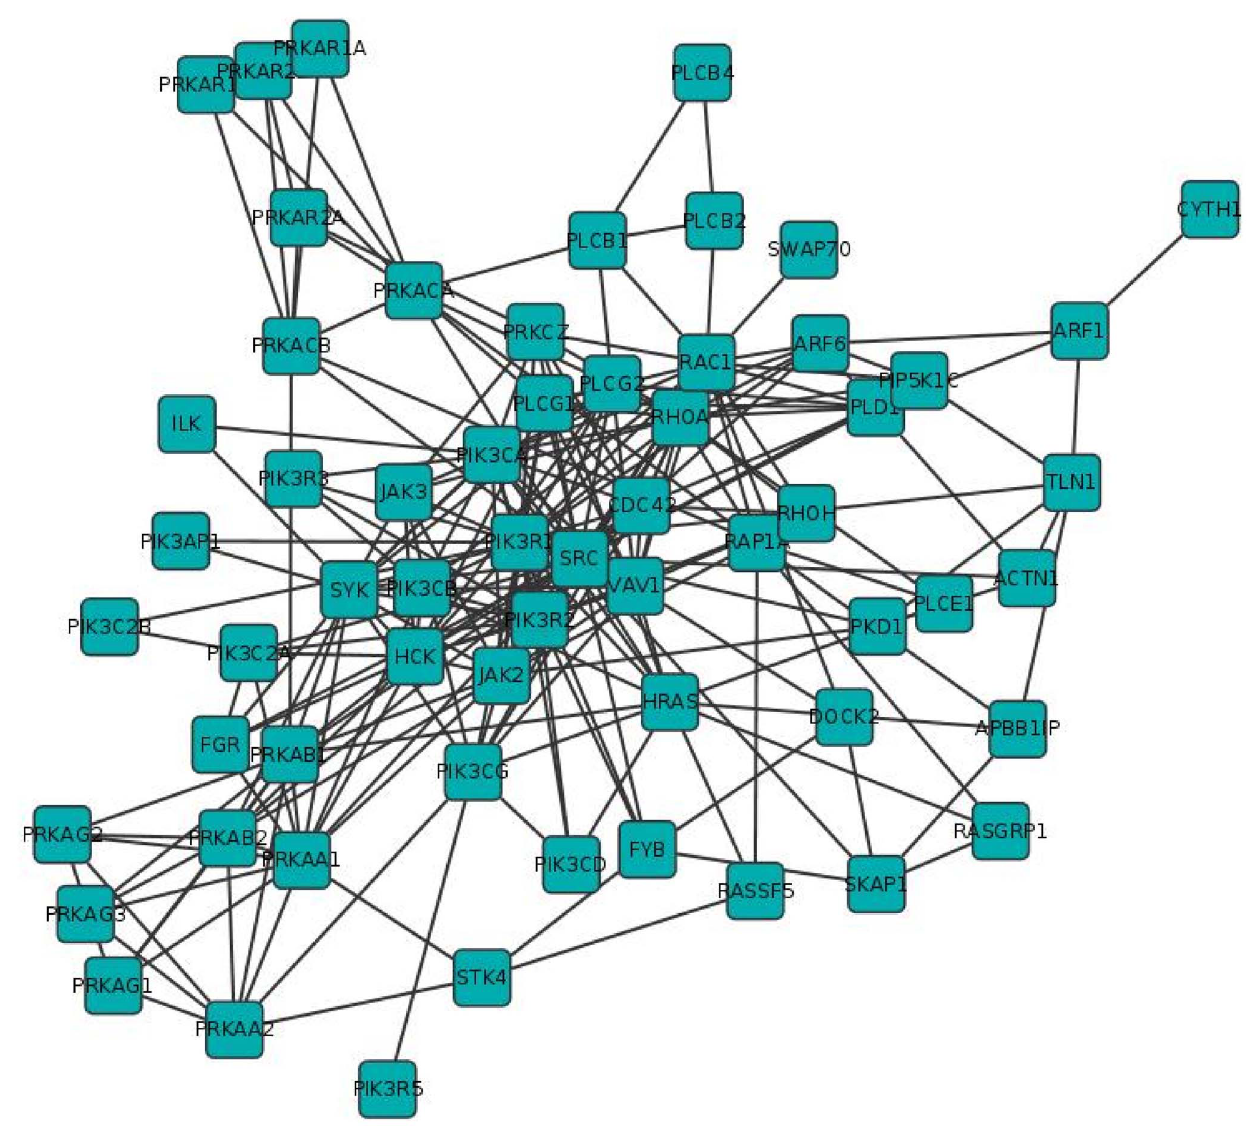
Figure 3. Integrin network. The network of the 61 integrins and 241 binary interactions, involved in the process of adhesion regulation.